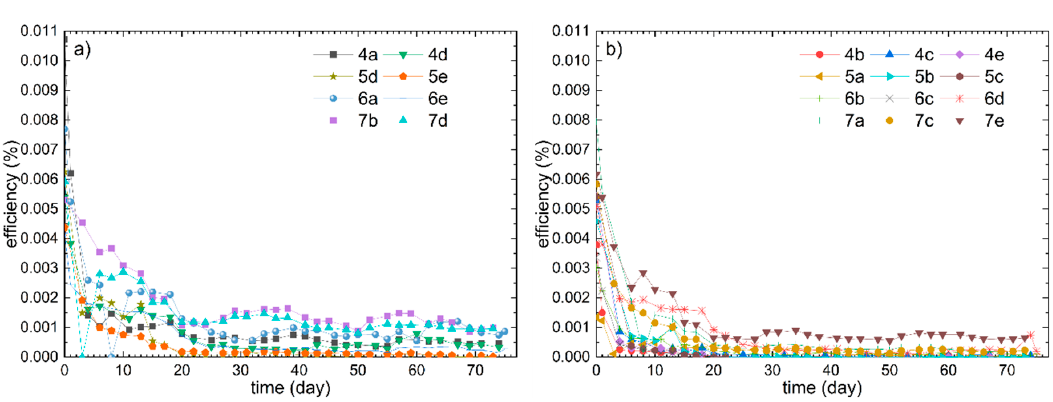
Figure 3. Efficiency curves of the two best DSSCs of samples 4 to 7, all with different MWs of PEO, are shown in ( a ) and the progressions of the further DSSCs of those samples are shown in ( b ). The following MWs were applied: 40 kg/mol in sample 4, 100 kg/mol in 5, 300 kg/mol in 6 and 1000 kg/mol in 7.